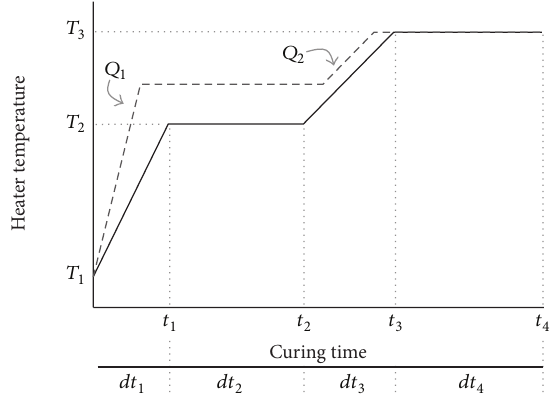
Figure 11: Schematic diagram of the two-step curing process. stage and cycle time. An optimum cure cycle that could reduce cycle time by more than 29%, compared to one-step cure, by adjusting dwell temperature, heating rate, and dwell time, was then proposed.